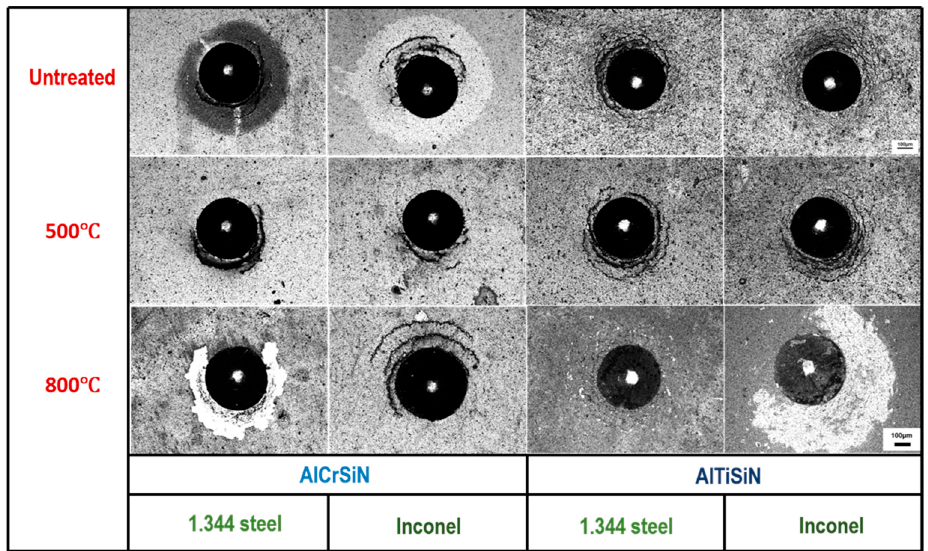
Figure 11. Confocal images of the Mercedes test at 613 N with a Rockwell C tip contrasted with different thermal treatments.